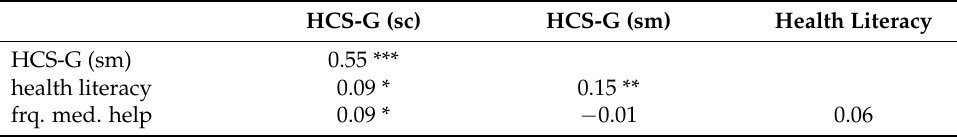
Table 6. Pearson correlations of health consciousness and criterion validity